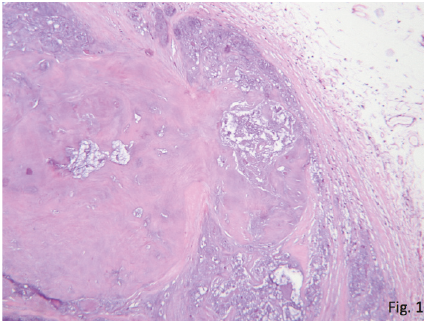
Figure 1: Well delimited and lobulated formation, consisting of cartilaginous appearance tissue (H-E, 50x).